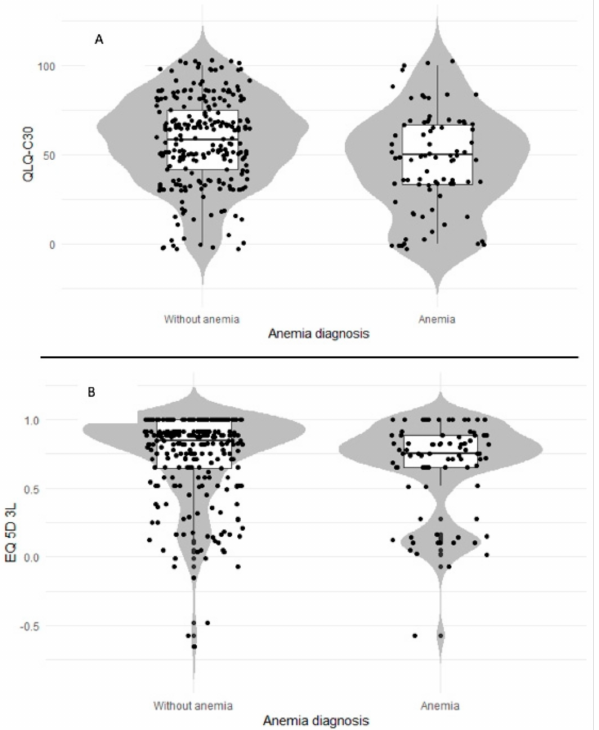
Figure 1. Patient data distribution and probability densities within different questionnaires. Patients with anemia are indicated as “cases” and those without anemia as “controls”. Violin plots for QLQ- c30 Global Health Status ( A ) and EQ–5D–3L Index ( B ). The plots indicate the distribution of the observed values (dots). The kernel density plot (grey line) represents the probability density function. Larger sections of the violin plot indicate a higher probability of observation at a given value, whereas thinner sections correspond to a lower